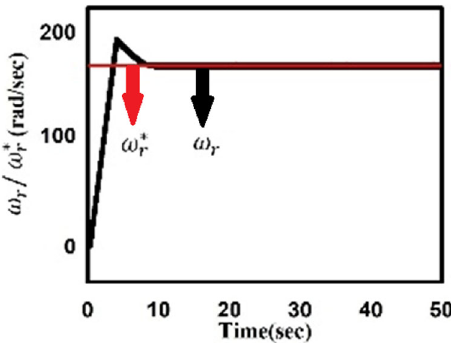
Fig. 13 FOC control-based speed